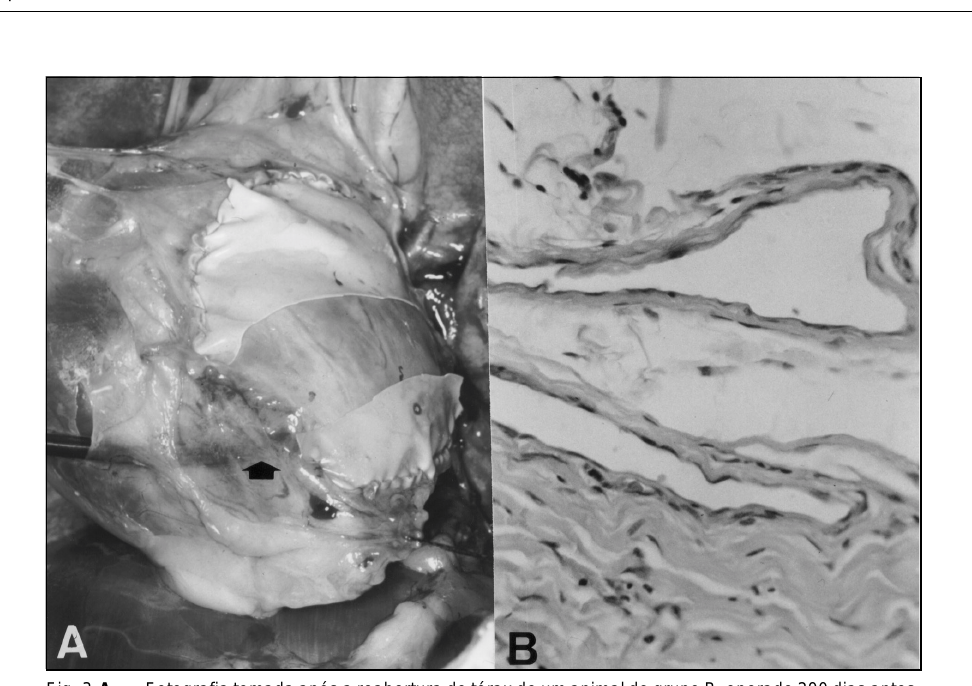
Fig. 3- A – Fotografia tomada após a reabertura do tórax de um animal do grupo B, operado 290 dias antes. O cateter, introduzido na cavidade pericárdica em direção à linha de sutura, não a ultrapassa (seta). Os vasos coronários podem ser vistos na superfície do coração, na área correspondente à membrana de látex natural, parcialmente removida. B – Fotomicrografia do tecido que